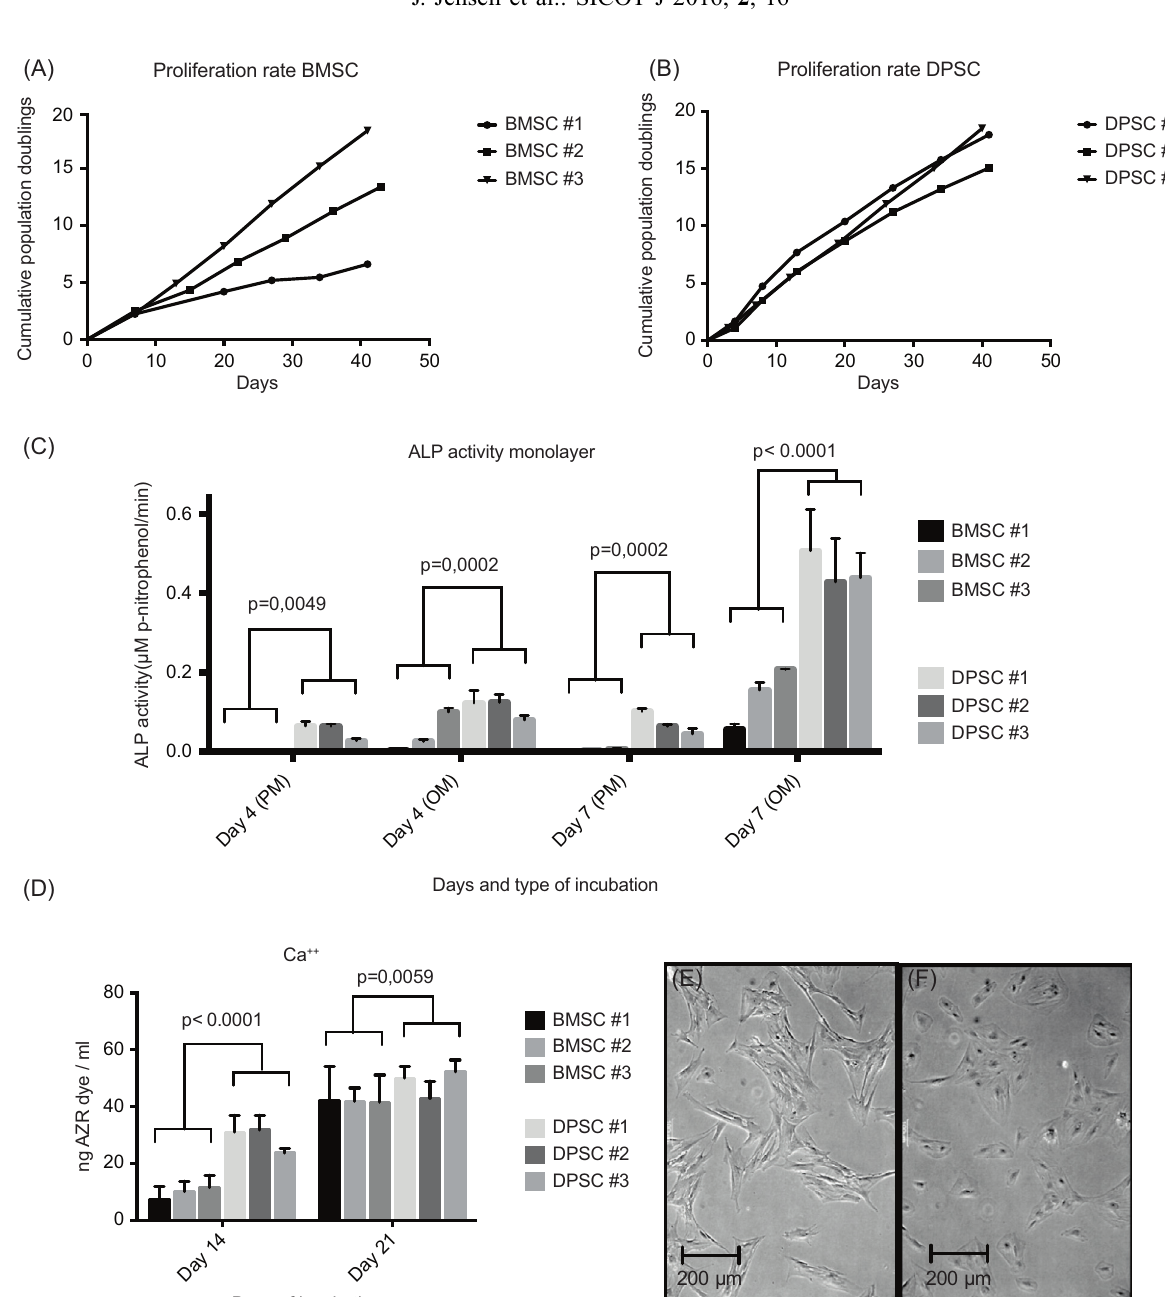
Figure 2. In vitro monolayer culture study of BMSCs and DPSCs. The accumulated population doublings of BMSC #1-3 (a) and DPSC #1-3 (b) are depicted as points on graph with connecting lines. The graphs illustrate the diversion in PD rate in between the three BMSCs compared with the uniform PD curves of the DPSCs. The ALP activity (c) and concentration of Ca ++ (d) analyses are presented as mean histograms of each individual cell line with error bars representing the technical standard deviations. P -values are based on a combined group mean for each cell type. Microscope images of BMSCs (e) and DPSCs (f) are represented from day one in the monolayer experiment setup. The morphological difference between the two cell lines is